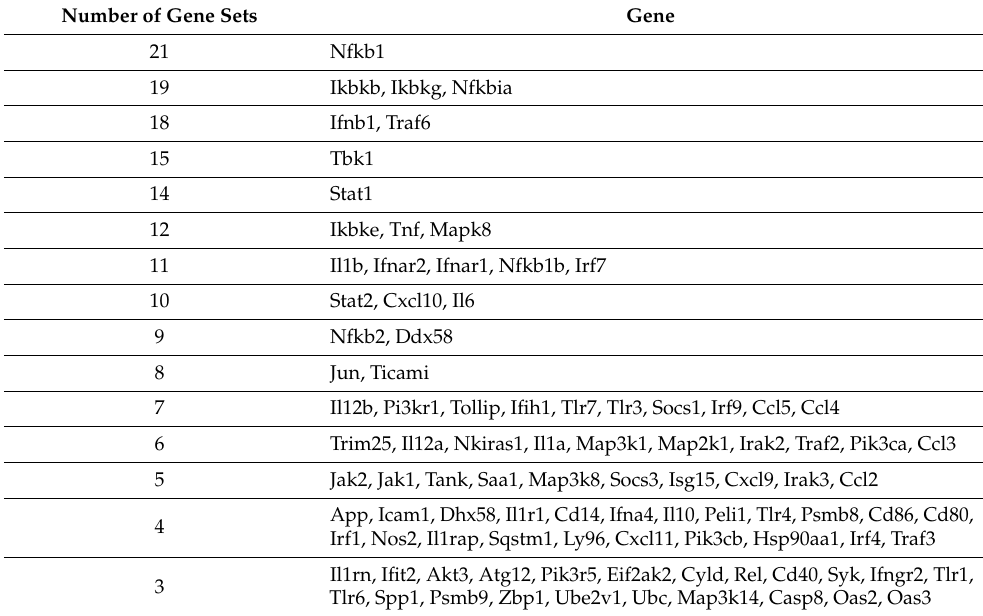
Table 4. Leading-edge genes shared by type I IFN signaling pathways in cluster